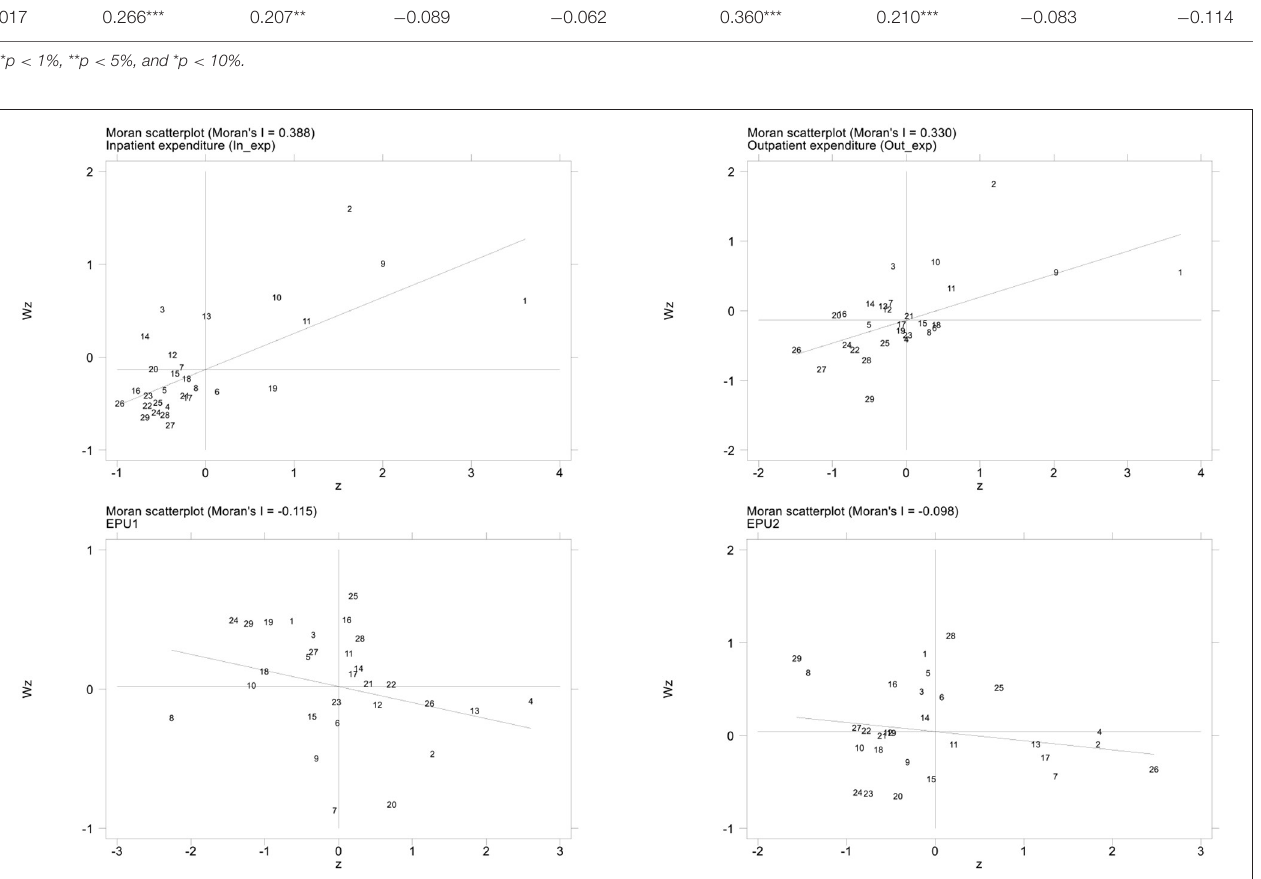
expenditure in neighboring or economically connected